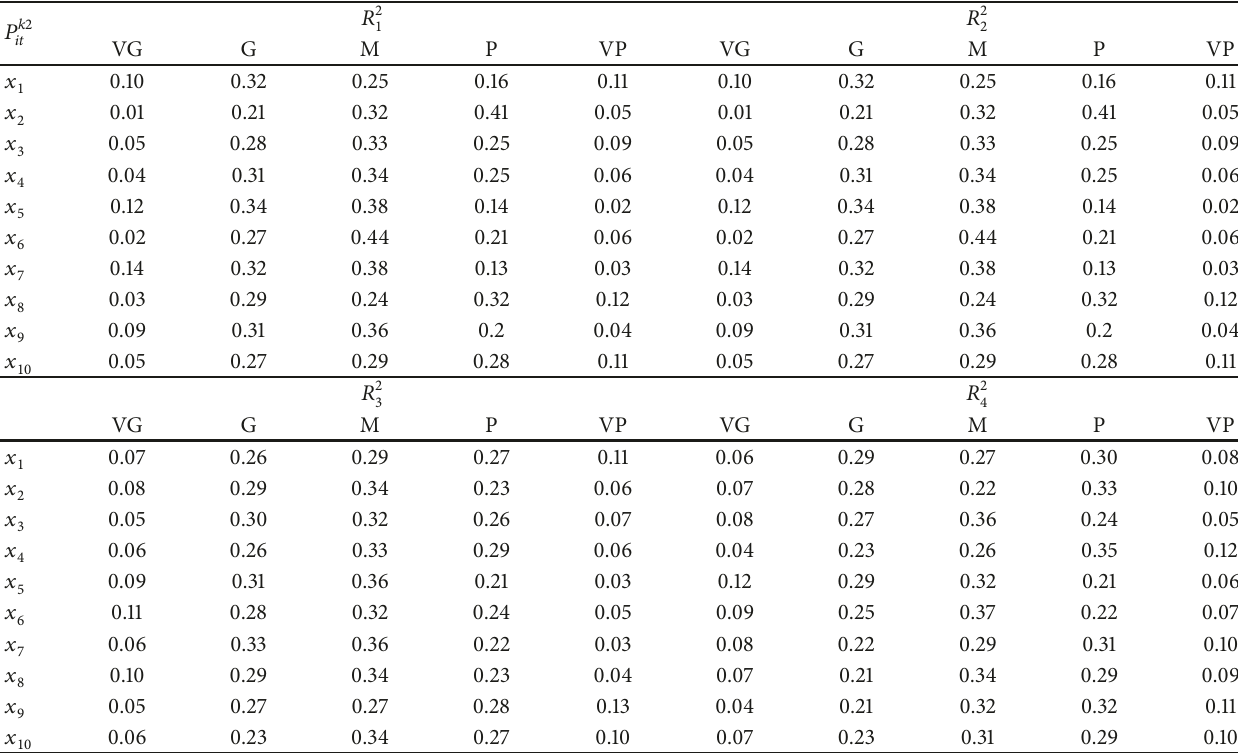
Table 4: The evaluation values of the dimensions of reputation.